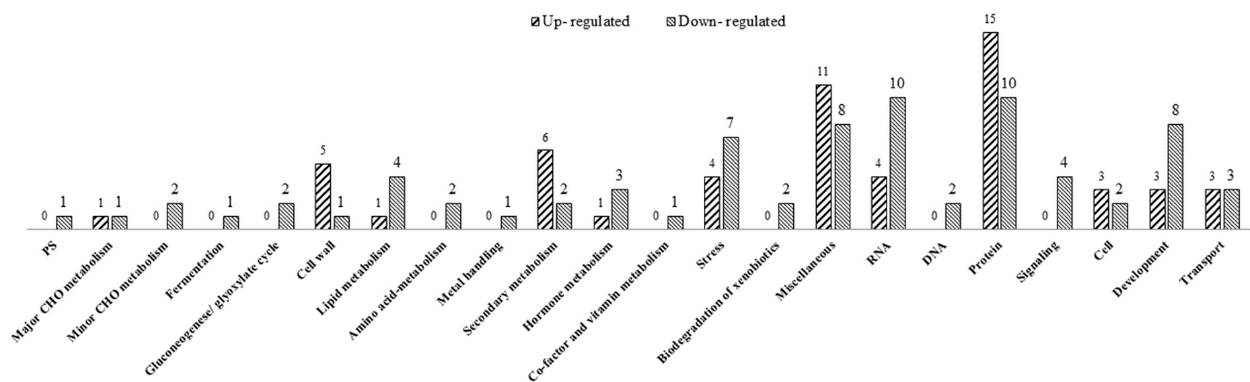
Figure 2. Heat map showing the expression patterns of differentially expressed genes in panicles under the fertile and sterile conditions.